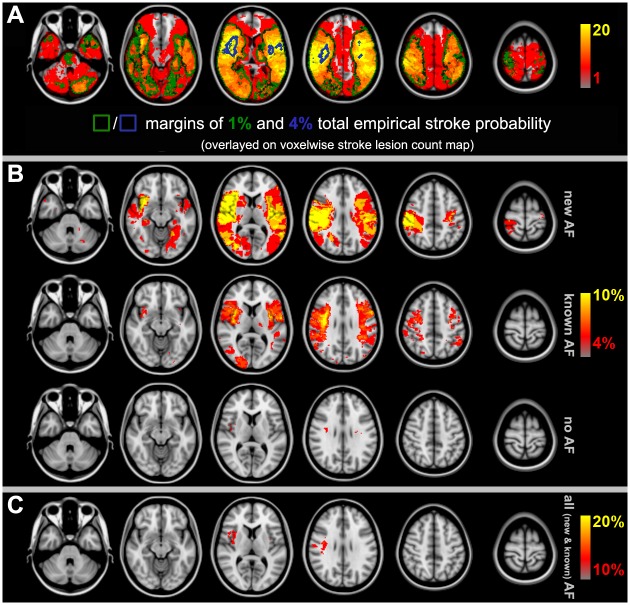
Voxelwise stroke lesion counts for the whole cohort and the diagnostic subgroups of different AF status.(A): Voxelwise stroke lesion counts and the margins of 1% and 4% total empirical stroke probability for the entire cohort of 582 acute ischemic stroke patients. Note the accumulation of ischemic lesions in the right insula, as illustrated by the 4% stroke probability margin. (Red-to-yellow: stroke lesion counts scaled between 1 to 20 lesions per voxel; green: margin of 1% total empirical stroke probability; blue: margin of 4% total empirical stroke probability). (B): Voxelwise empirical stroke probabilities for patients with new (top), known (middle) and without (bottom) AF. Smaller infarct volumes in patients without AF (cf. Fig 3) lead to less overlap of the ischemic lesions across subjects and thus much fewer voxels above the 4% empirical stroke probability threshold (set to display for illustration) while for the larger strokes of new and known AF ischemic lesions accumulate in both middle cerebral artery territories and centrally around the insula, in particular. (C): Voxelwise empirical stroke probabilities (thresholded at 10%) reveal that AF (new and known combined) leads to an accumulation of stroke lesions in the right MCA territory and insula, in particular. (AF: atrial fibrillation; MCA: middle cerebral artery).